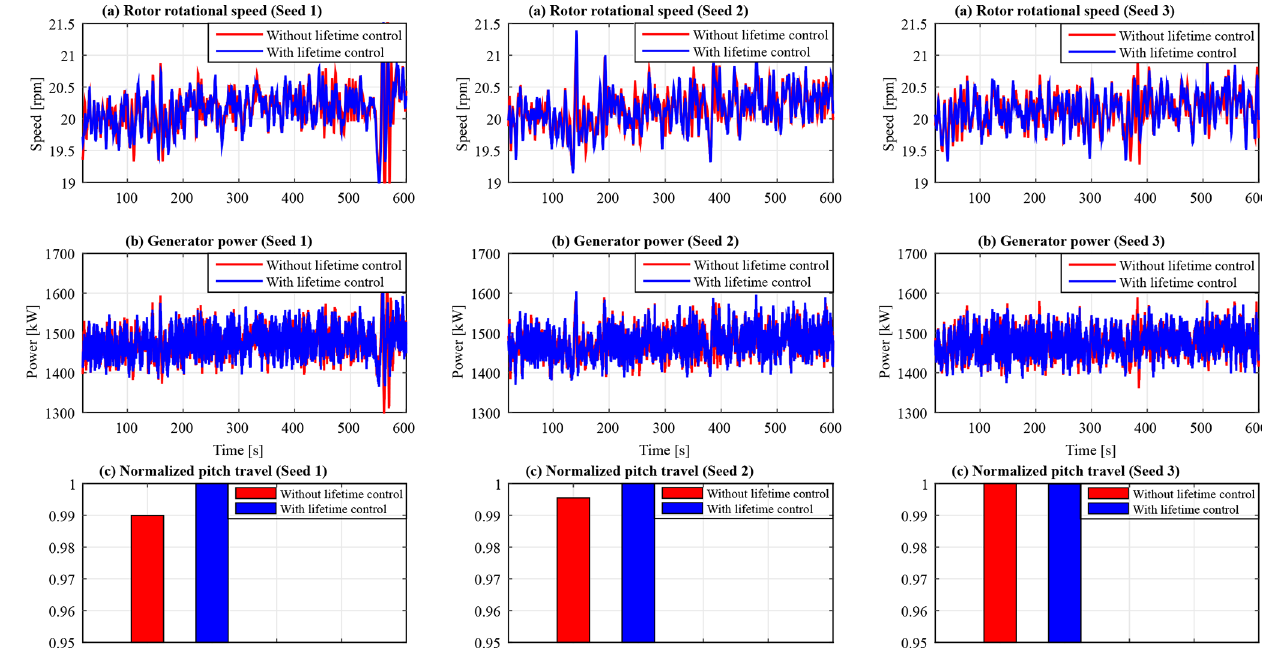
Figure 12. Speed and power regulation performance and pitch actuator usage for 14ms − 1